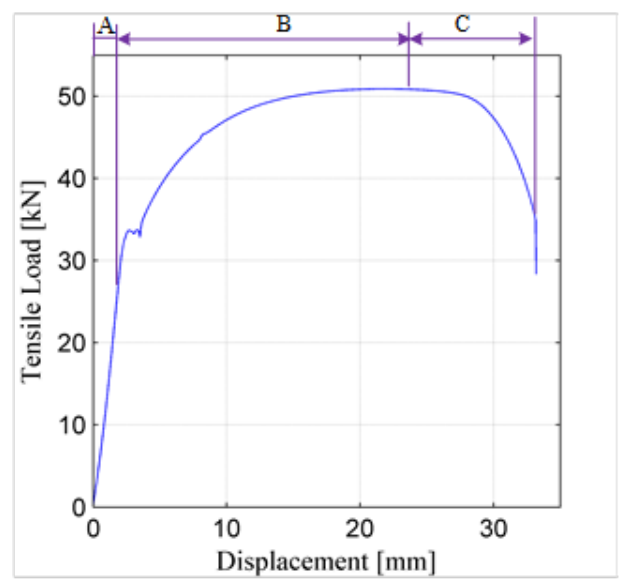
Figure 8. Deformation curve of sample L4 under tensile force. (A—Elastic deformation stage; B—Plastic deformation stage; C—Necking stage).